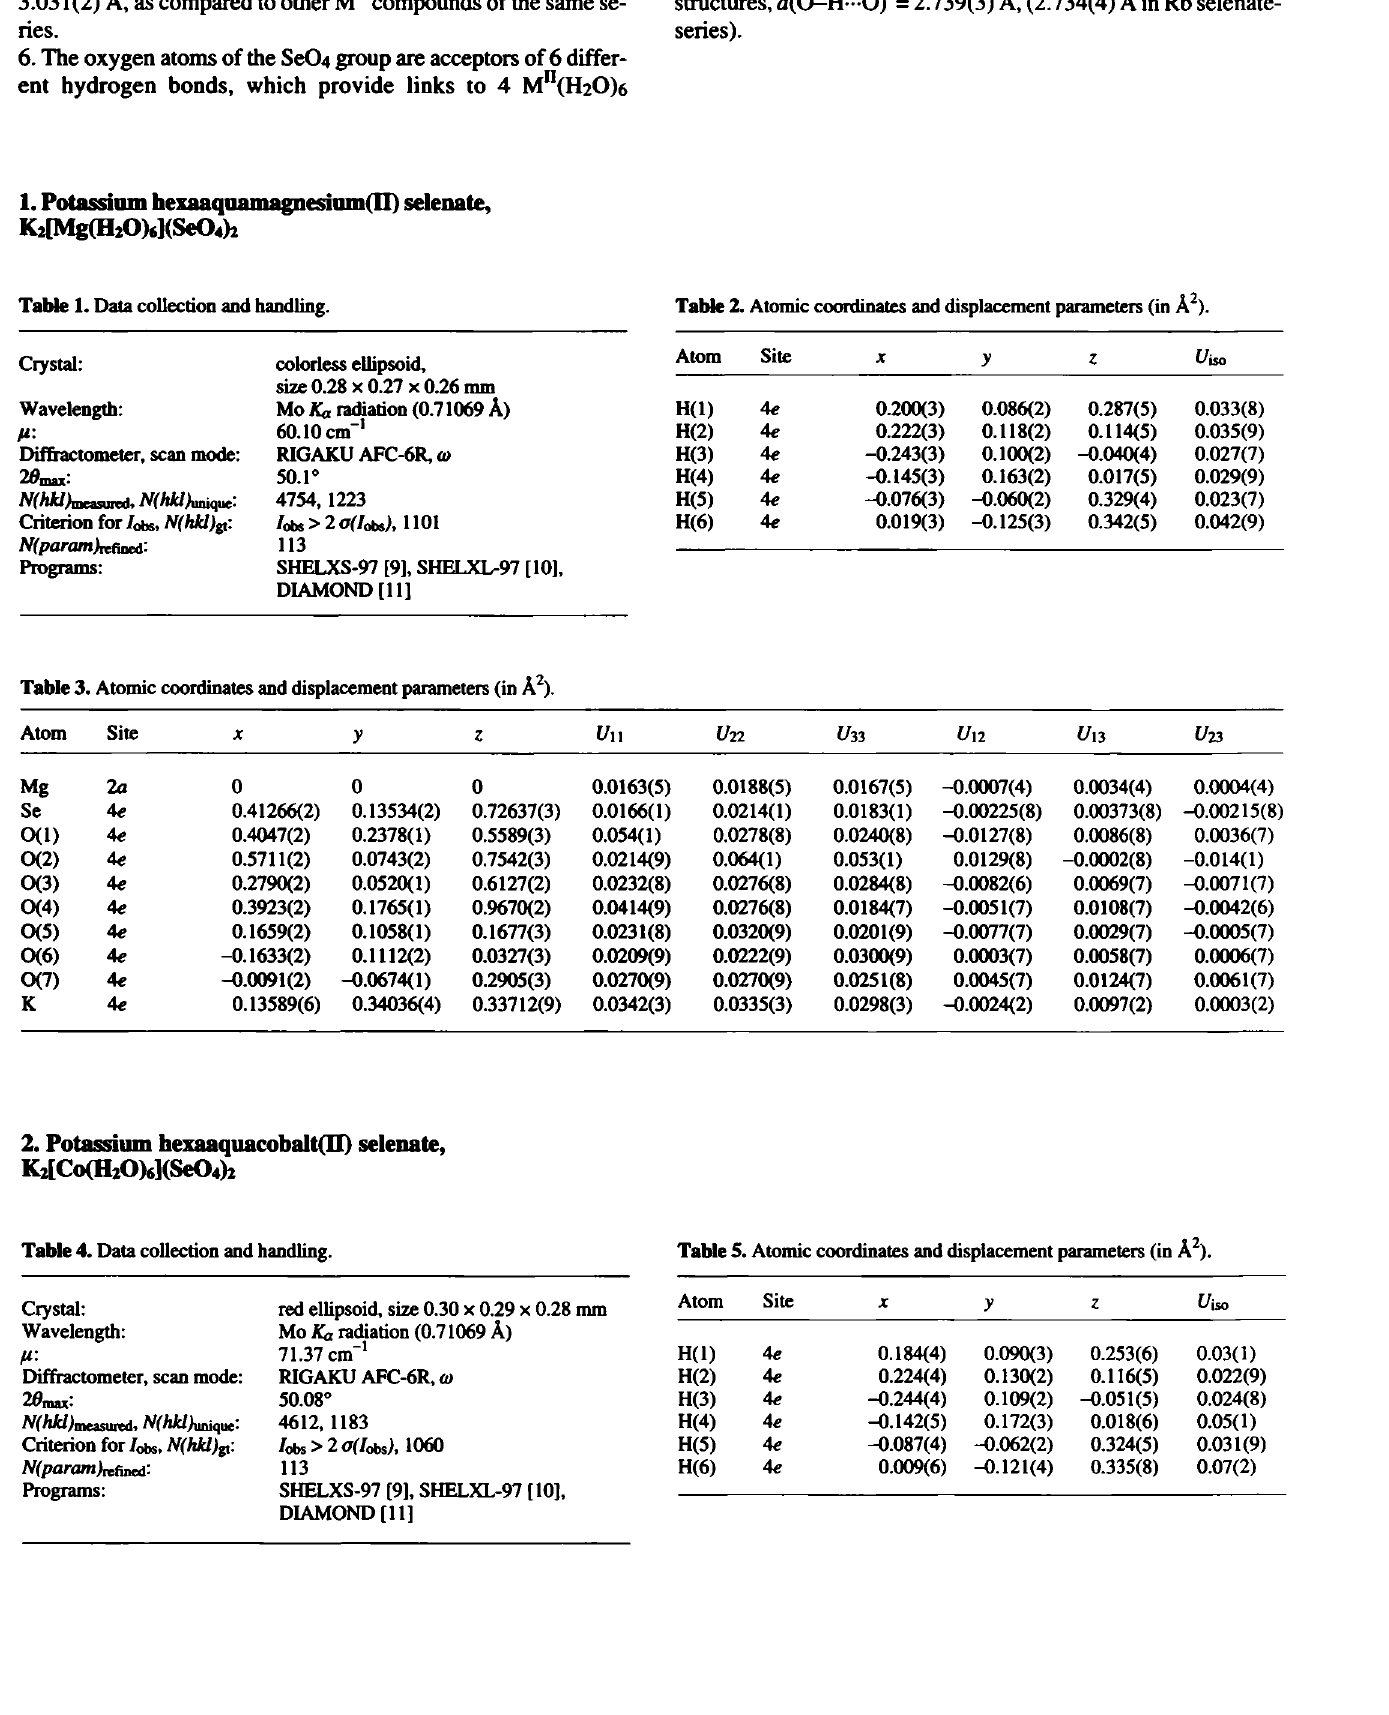
Table 1. Data collection and handling. Table 2. Atomic coordinates and displacement parameters (in Â 2 ).